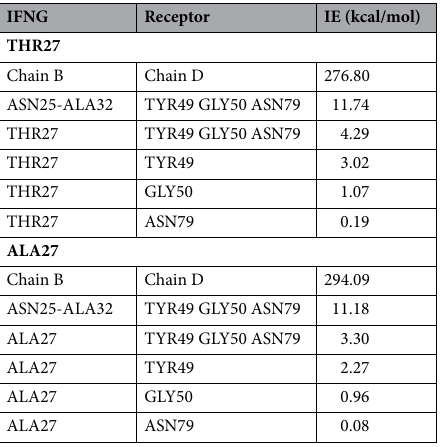
Table 1. Comparison of the interaction energy using AMBER forcefield of IFN-γ T27 and A27 with its receptor. The selected amino acids in 5 Å interface were explored.